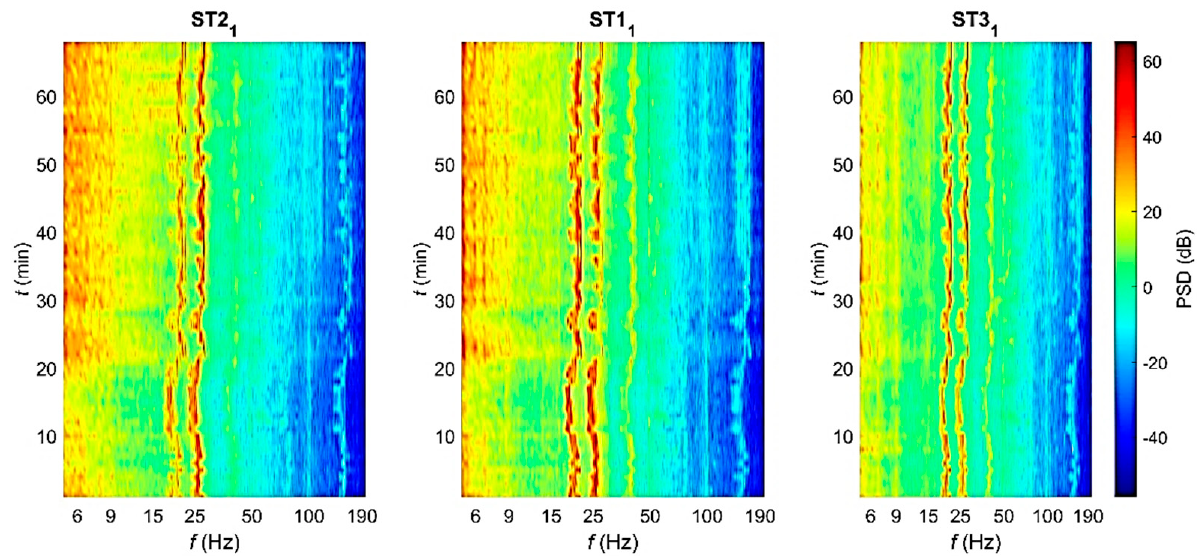
Figure 12. Two-dimensional PSD characteristics gathered for three measuring stations within 70